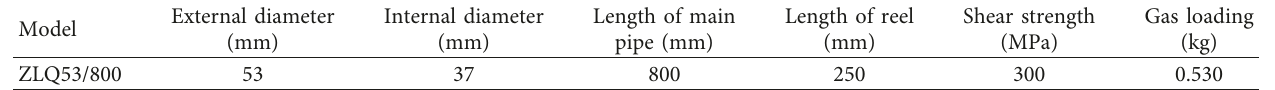
Table 1: Specifications of liquid CO